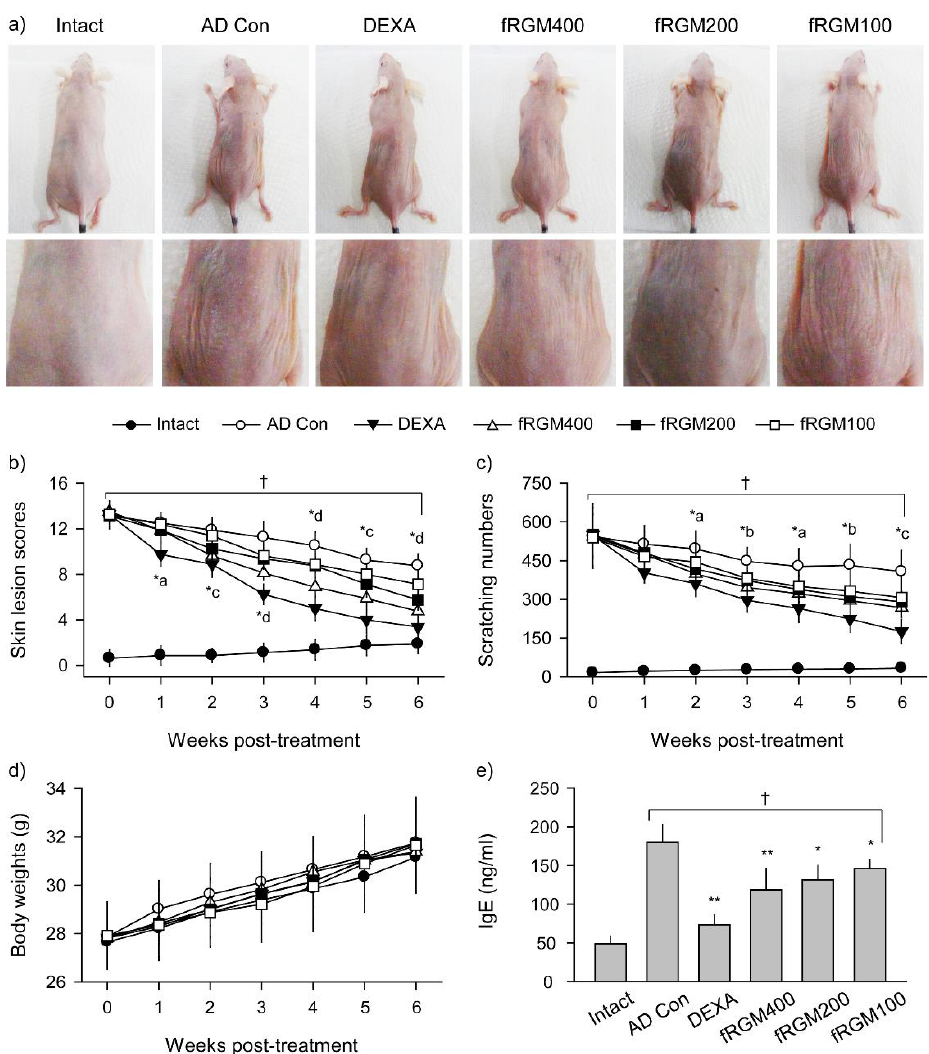
Figure 1. Effects on AD-like symptoms and production of IgE. ( a ) Representative images of skin lesions. ( b ) Skin severity scores. ( c ) Scratching numbers. ( d ) Body weight changes. ( e ) Serum levels of IgE. Values are represented as means ± standard deviations (SDs). †: p < 0.05 vs. the Intact group; **: p < 0.01 and *: p < 0.05 vs. the AD Con. *a, *b, *c and *d: p < 0.05 in DEXA, in DEXA and